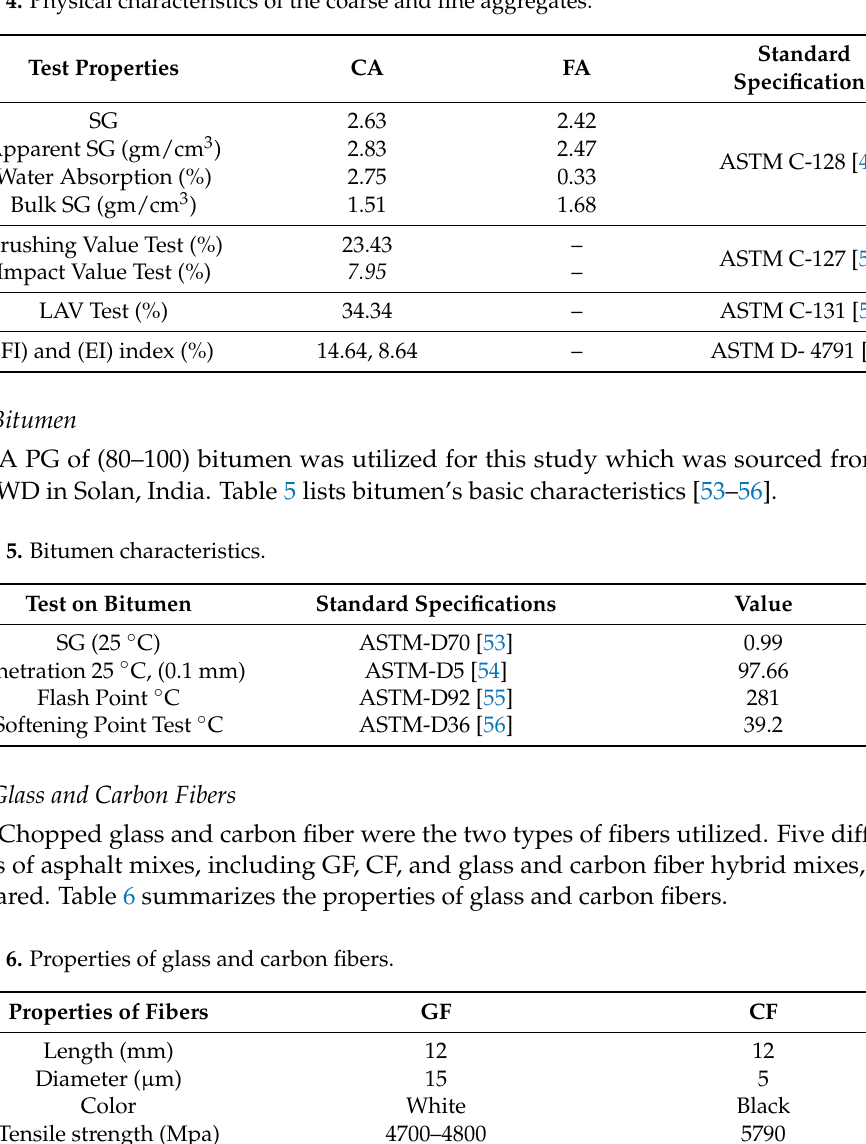
Table 4. Physical characteristics of the coarse and fine aggregates.